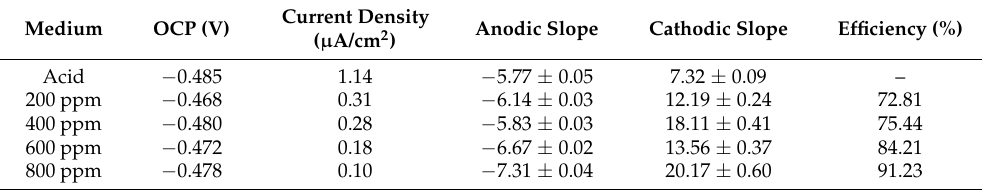
Table 4. Polarization parameters of 1 h-immersed MS sample in acid solution with and without inhibitor.